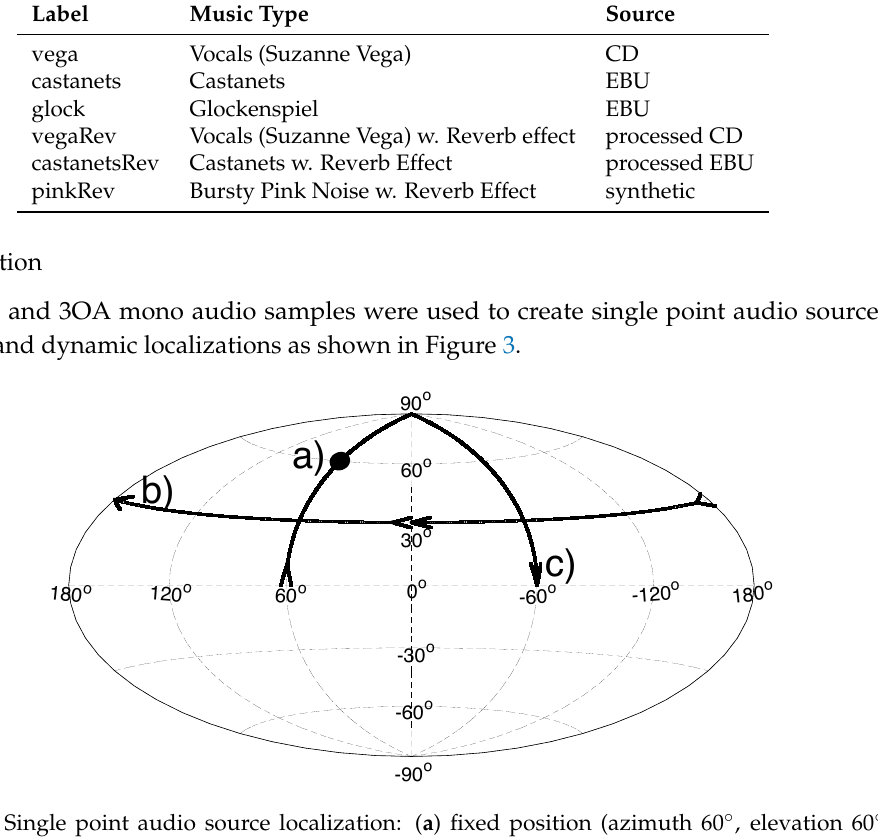
Figure 3. Single point audio source localization: ( a ) fixed position (azimuth 60 ◦ , elevation 60 ◦ ), ( b ) audio source moving horizontally above the listener’s head, ( c ) audio source moving up in elevation on the left hand side, then down on the right hand side. Reproduced from